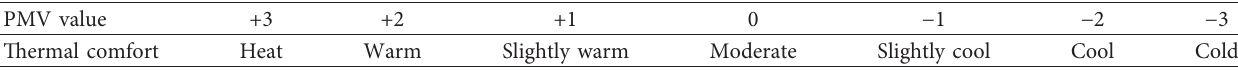
Table 1: Level 7 indicators of PMV.